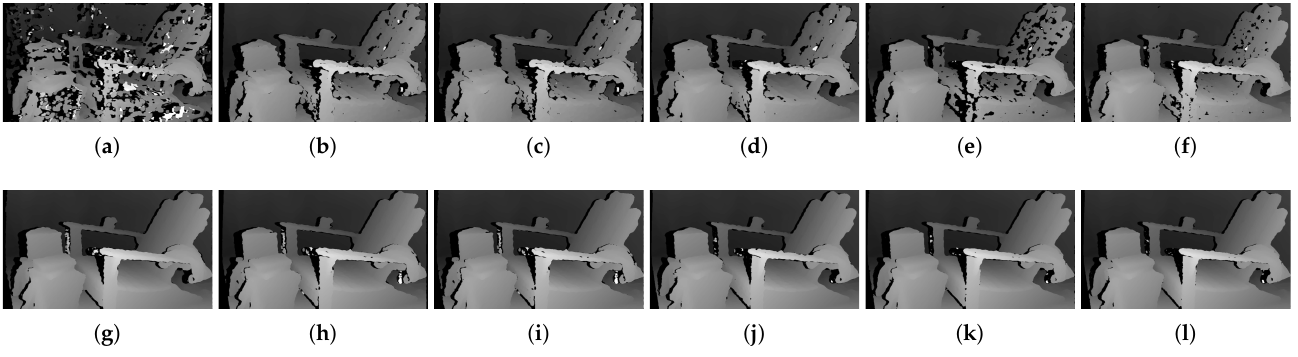
Figure 19. Estimated disparity images of the combinations of cost and image filter using the window- based stereo method, according to low and high parameters for the number of pattern dots . The images in the top row show disparities with the small number of pattern dots , and the images in the bottom row show those with the large number of pattern dots , respectively. ( a ) Window, SAD. ( b ) Window, Mean/SAD. ( c ) Window, LoG/SAD. ( d ) Window, BilSub/SAD. ( e ) Window, Rank/SAD. ( f ) Window, Census. ( g ) Window, SAD. ( h ) Window, Mean/SAD. ( i ) Window, LoG/SAD. ( j ) Window, BilSub/SAD. ( k ) Window, Rank/SAD. ( l ) Window,